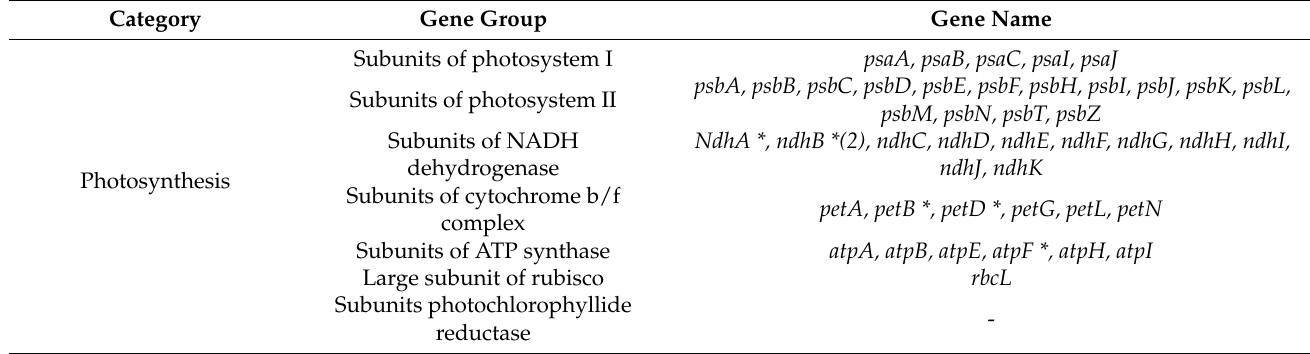
Table 1. List of genes in the B. schreberi cv. ‘Mahu Chuncai’ chloroplast genome. Category Gene